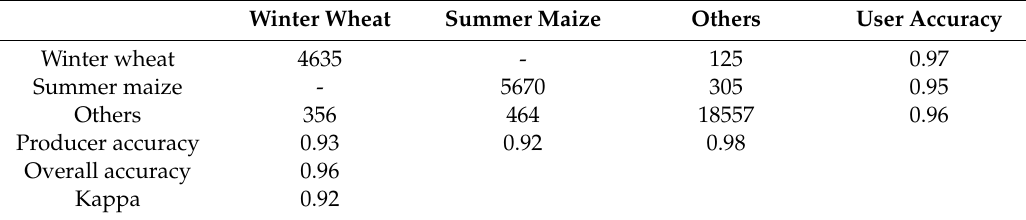
Table 4. Accuracy assessment using the interpreted images from Google Maps for the NCP.